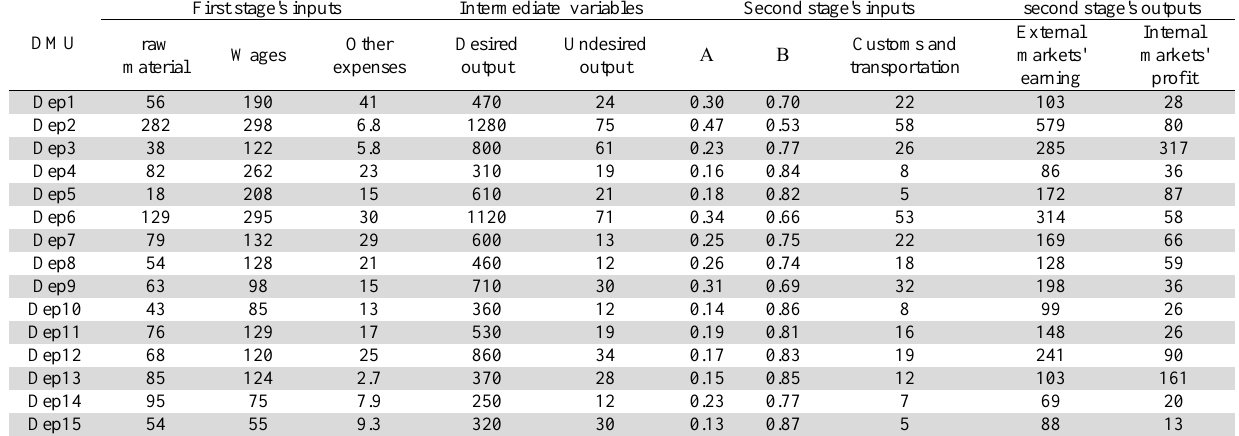
Data set of Iranian Handmade Carpet Company (IHCC's archives, 2013)